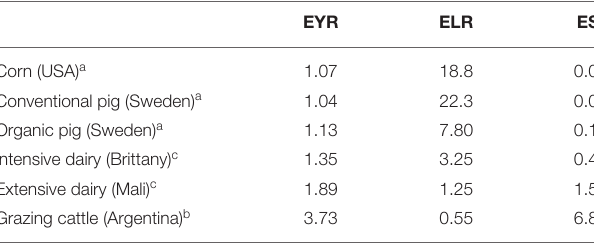
TABLE 4 | Yield and sustainability within agricultural systems assessed in terms of embedded energy (“emergy”) and described by three ratios (EYR, emergy yield ratio; ELR, environmental load ratio; ESI, emergy sustainable